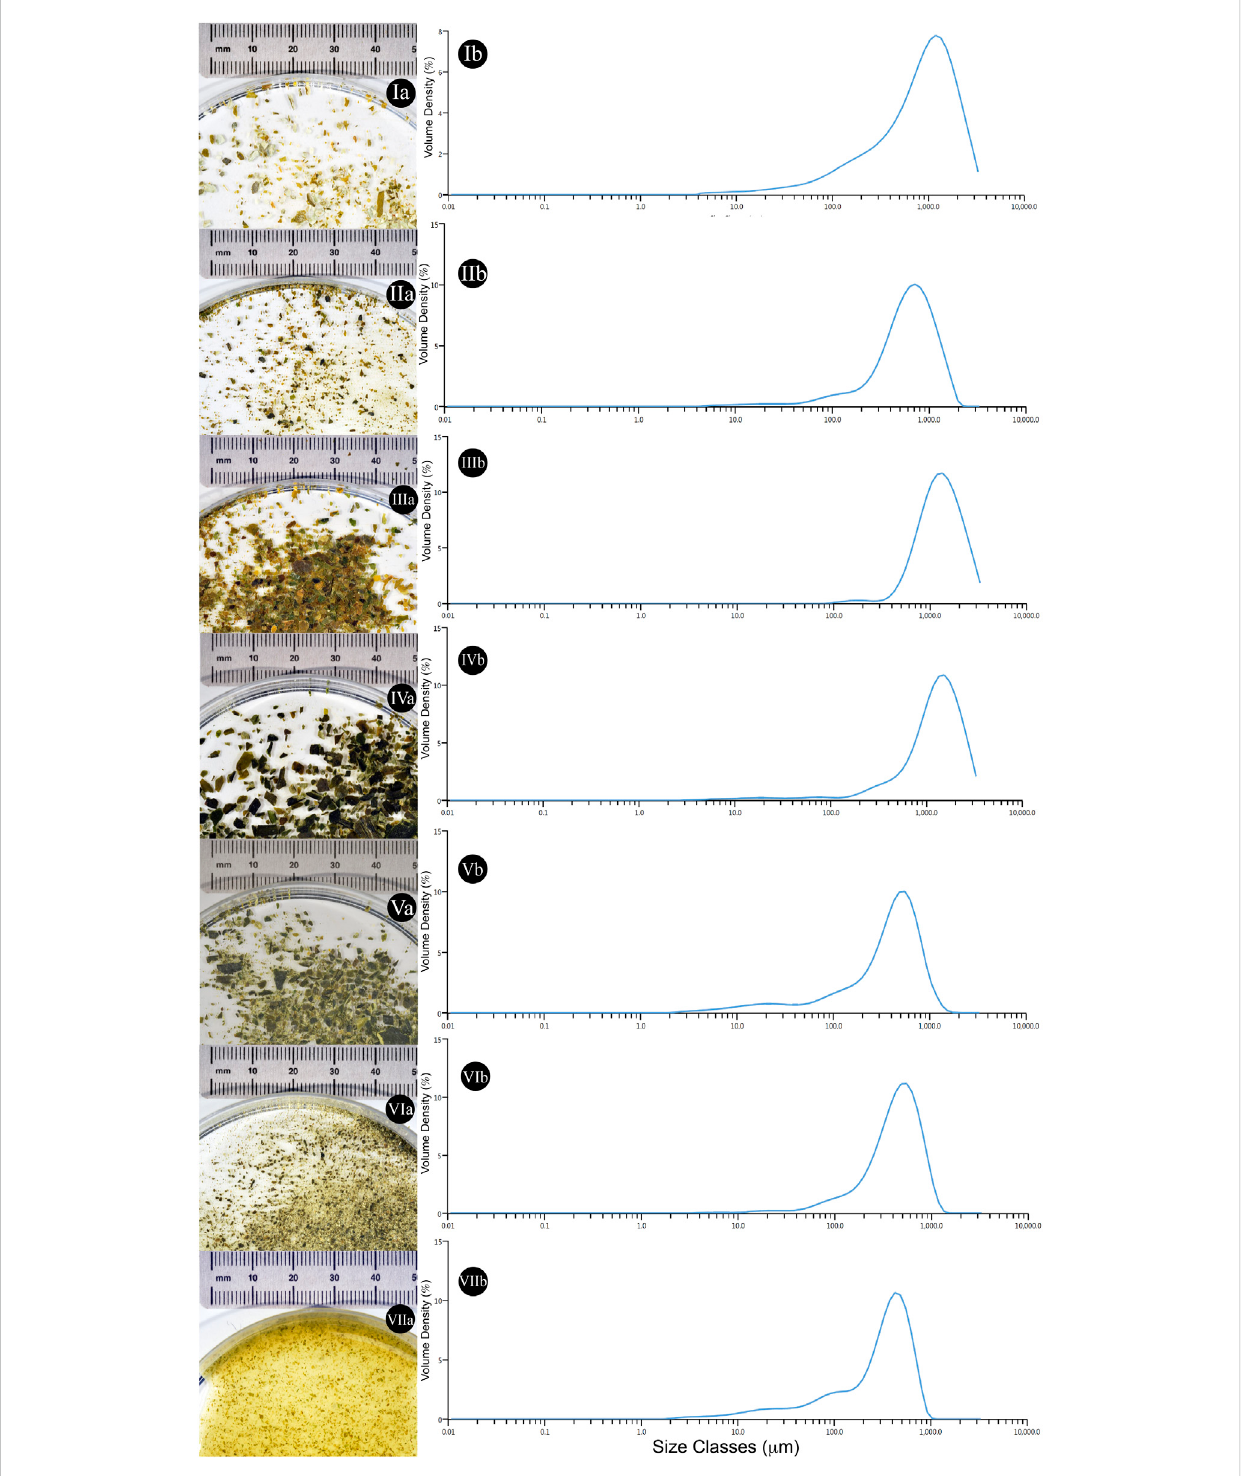
FIGURE 6 Qualitative and quantitative particle size evaluation from differentalgal samples. (Ia) Ground Alaria esculenta starting material provided by SAMS (Oban, UK) (Ib) Average particle size dispersity of the starting material (n = 3). (IIa) Ground Laminaria digitata starting material provided by SAMS (Oban, UK) (IIb) Average particle size dispersity of the starting material (n = 3). (IIIa) Ground Saccharina latissima starting material provided by SAMS (Oban, UK) (IIIb) Average particle size dispersity of the starting material (n = 3) (IVa) Commercial Laminaria digitata fl akes (IVb) Average particle size dispersity of the starting material (n = 3).